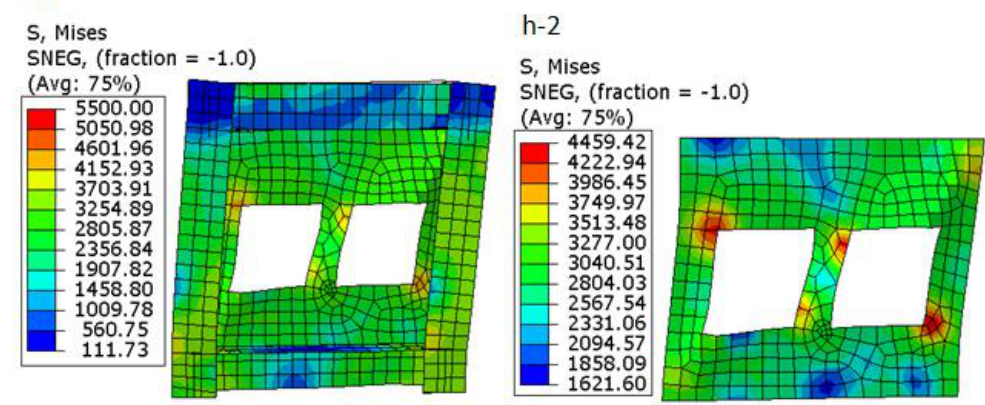
Figure 23. Von Mises stress and displacement for concrete part (g-3) stress and (g-4) displacement. Buildings 2018 , 8 , x FOR PEER REVIEW